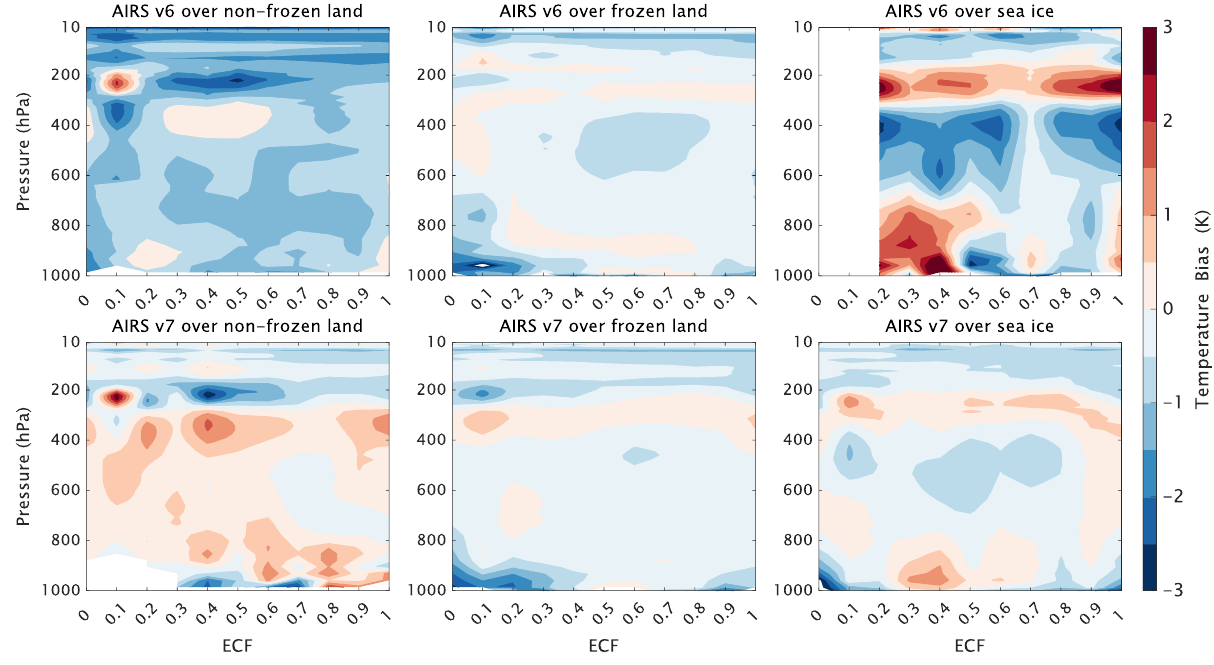
Figure 9. The mean bias of the AIRS temperature profiles as a function of the AIRS ECF over different subclasses. The results for v6 are shown in the top row and those for v7 in the bottom row. The columns from left to right represent retrievals over nonfrozen land, frozen land, and sea ice, respectively.